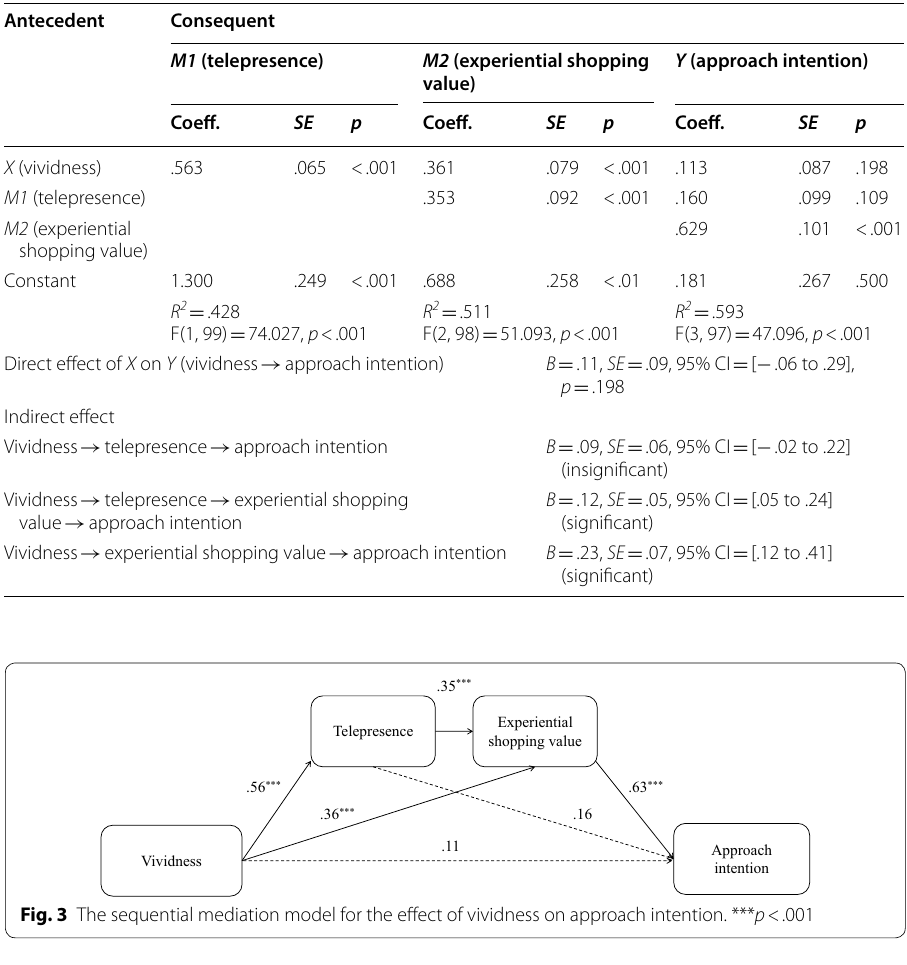
Table 3 Model coefficients of the sequential mediation model: the effect of vividness on approach intention